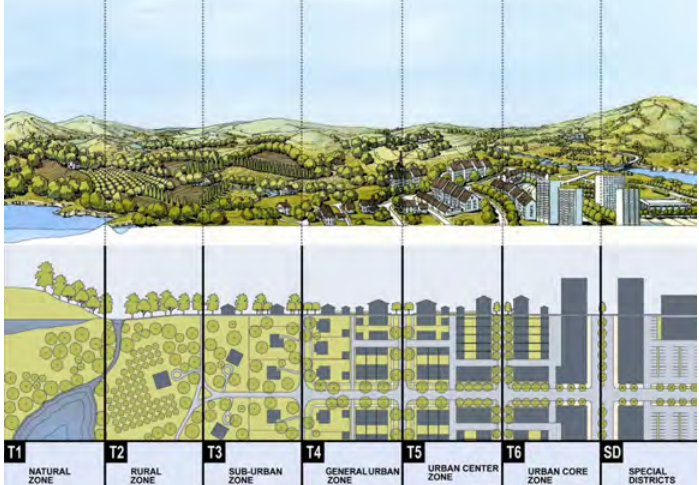
Figure 1. Standardtransect matrix of Form-Based Code